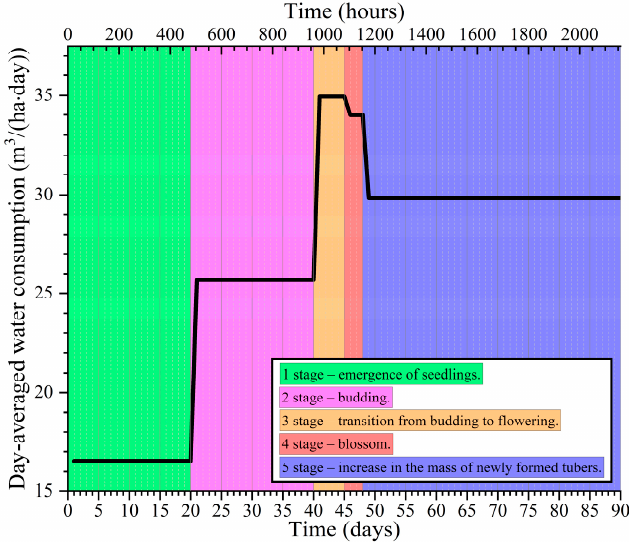
Figure 4. Dynamics of substrate moisture decrease rate for microplants and minitubers. Vertical do tt ed lines indicate the location of the extrema of the dependencies under consideration.